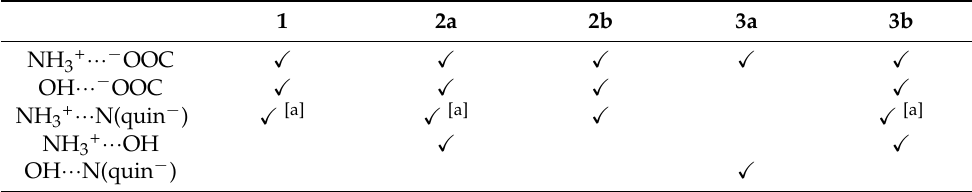
Table 3. Heterosynthon occurrence in the structures of title compounds.